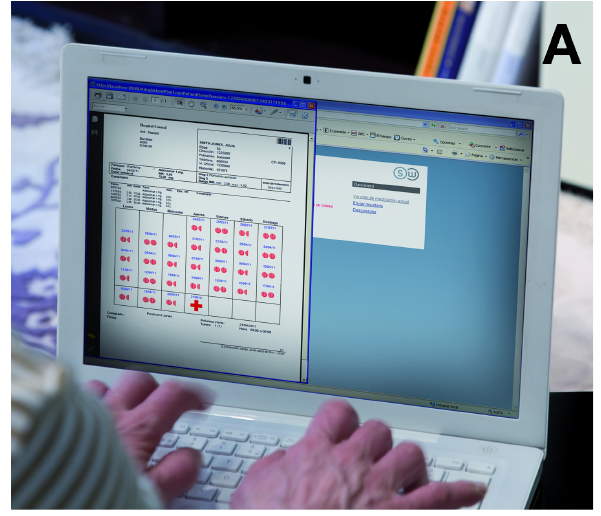
Figure 1. Illustrative pictures of the SintromacWeb software. In patient’s personal area (panel A), current medication schedule is available; INR results are introduced and sent to health care center. In physician’s area (panel B), the hematologist analyzes the data and introduces new medication schedule for